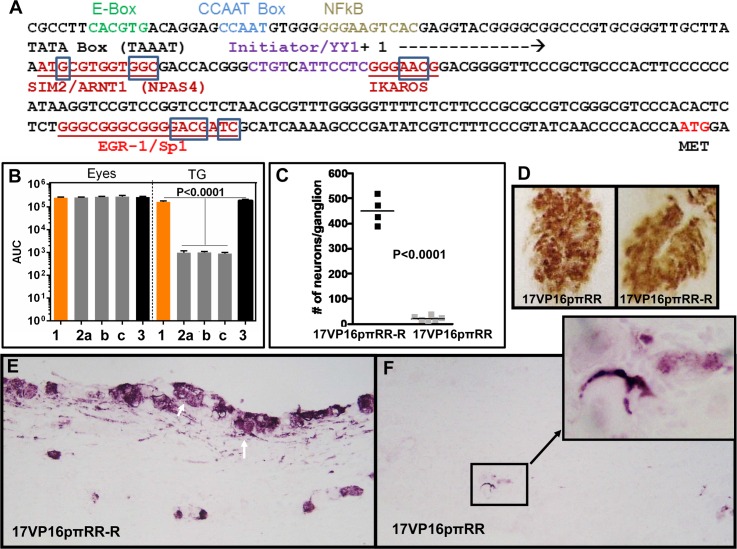
Entry into lytic infection in TG neurons is regulated by sequences in the VP16 promoter.A) Sequence of the proximal VP16 promoter. Putative regulatory sites identified previously [83,84] are color coded and labeled above the sequence. Potential sites known to confer reciprocal regulation to neuronal genes are underlined and in red. The boxed nucleotides were altered as detailed in methods. B) Replication kinetics on eyes and in TG on days 2 through 10 pi is shown as the area under the curve (AUC). Tissues from 3 mice were examined for each time point. 1 = 17syn+, 2a, b, c are three independently derived isolates of the VP16 promoter mutant 17VP16pπRR and 3 = the genomically restored isolate 17VP16pπRR-R. C) Mice were infected on the cornea with the VP16 promoter mutant 17VP16pπRR or its genomically restored isolate 17VP16pπRR-R. At 72 hrs pi tissues were harvested and processed for the whole tissue immunohistochemical detection of VP16 and the number of VP16 positive neurons enumerated. The data are shown as a scattergram with each point representing the number of positive neurons in an individual TG. The difference between the groups was significant (p<0.0001, Student’s t-test). D) Representative photomicrographs of corneas stained for VP16 protein which is seen as a brown precipitate in characteristic lesions on the corneal surface (arrows). E) Representative photomicrographs of sectioned trigeminal ganglia infected with 17VP16pπRR-R stained immunohistochemically for VP16 (purple precipitate). Numerous cells including neurons identifiable by their large size, morphology and axonal tracts are positive in the TG infected with 17VP16pπRR-R the genomically restored isolate which is not different than WT 17syn+ (white arrows). F) Rare VP16 positive cells in the 17VP16pπRR infected TG were detected and did not appear to be neurons. One such area is boxed and shown enlarged in an inset micrograph. This region appears to be a small focus of positive support cells.